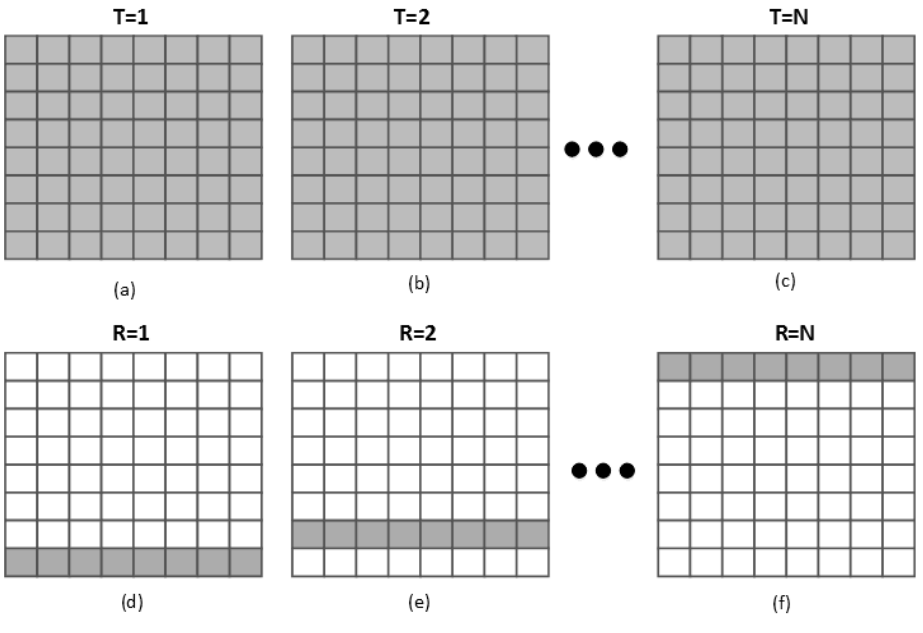
Figure 10. The sequence of transmit ( a – c ) and receive ( d – f ) events [19].